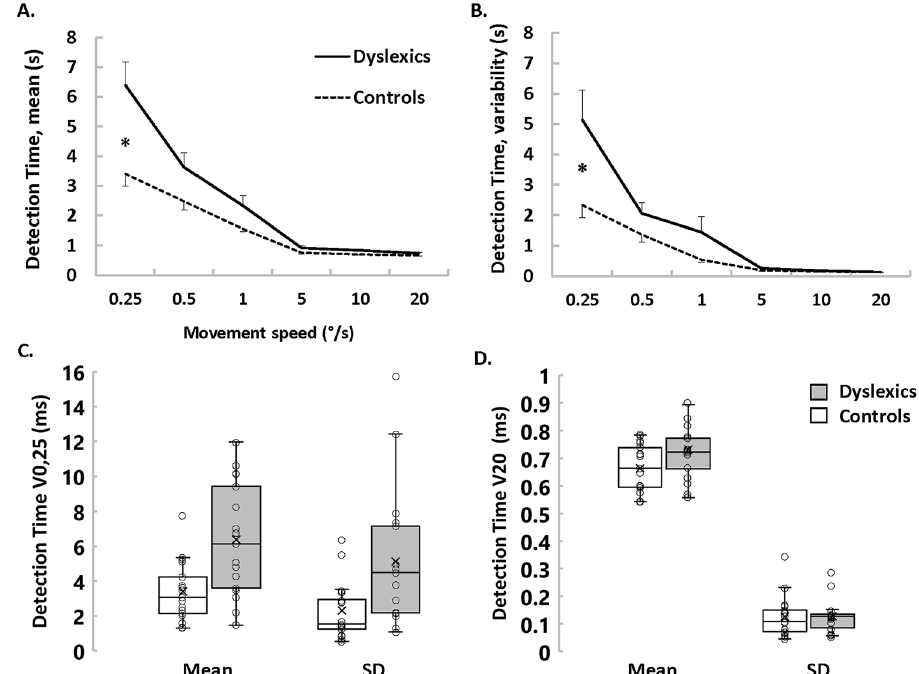
Figure 2. Proprioceptive detection times of passive motion at all tested speeds. ( A ) Mean detection time (± SE) for both groups. ( B ) Mean intra-participant variability of detection time (± SE) for both groups. ( C ) Box plots of mean and variable detection times at the slowest speed. The box lines indicate the 25th, 50th, and 75th percentiles, and the whiskers extend to the 5th and 95th percentiles. Dots display individual values (n = 17 in each group), and the cross indicates the average. ( D ) Box plots of mean and variable detection times at the highest speed. Same organization as panel ( C ).